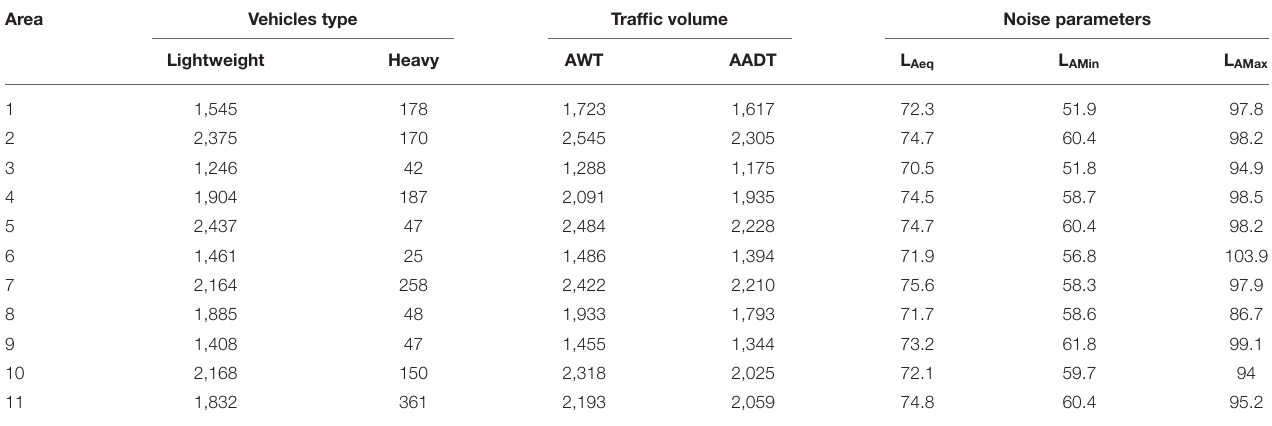
TABLE 1 | Measurement